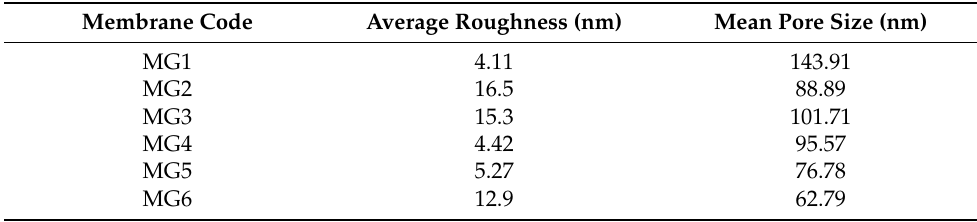
Table 2. Membrane average roughness and mean pore size.